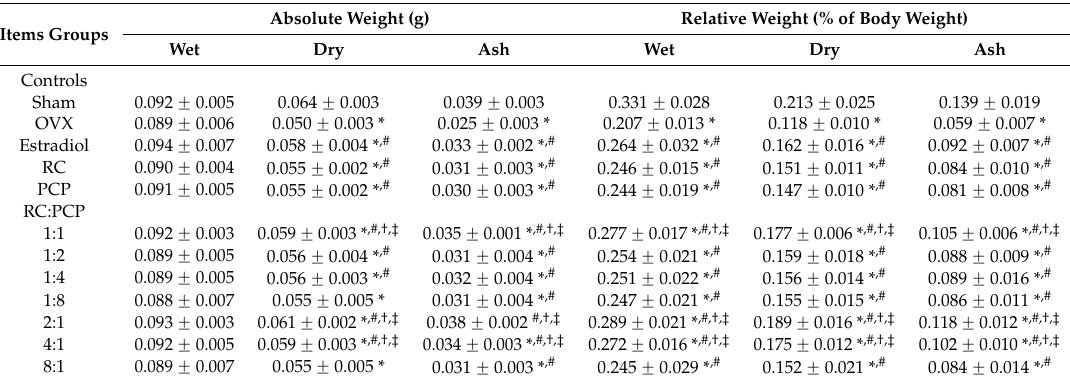
Table 6. Right femur weights in sham-operated or OVX ddY mice.